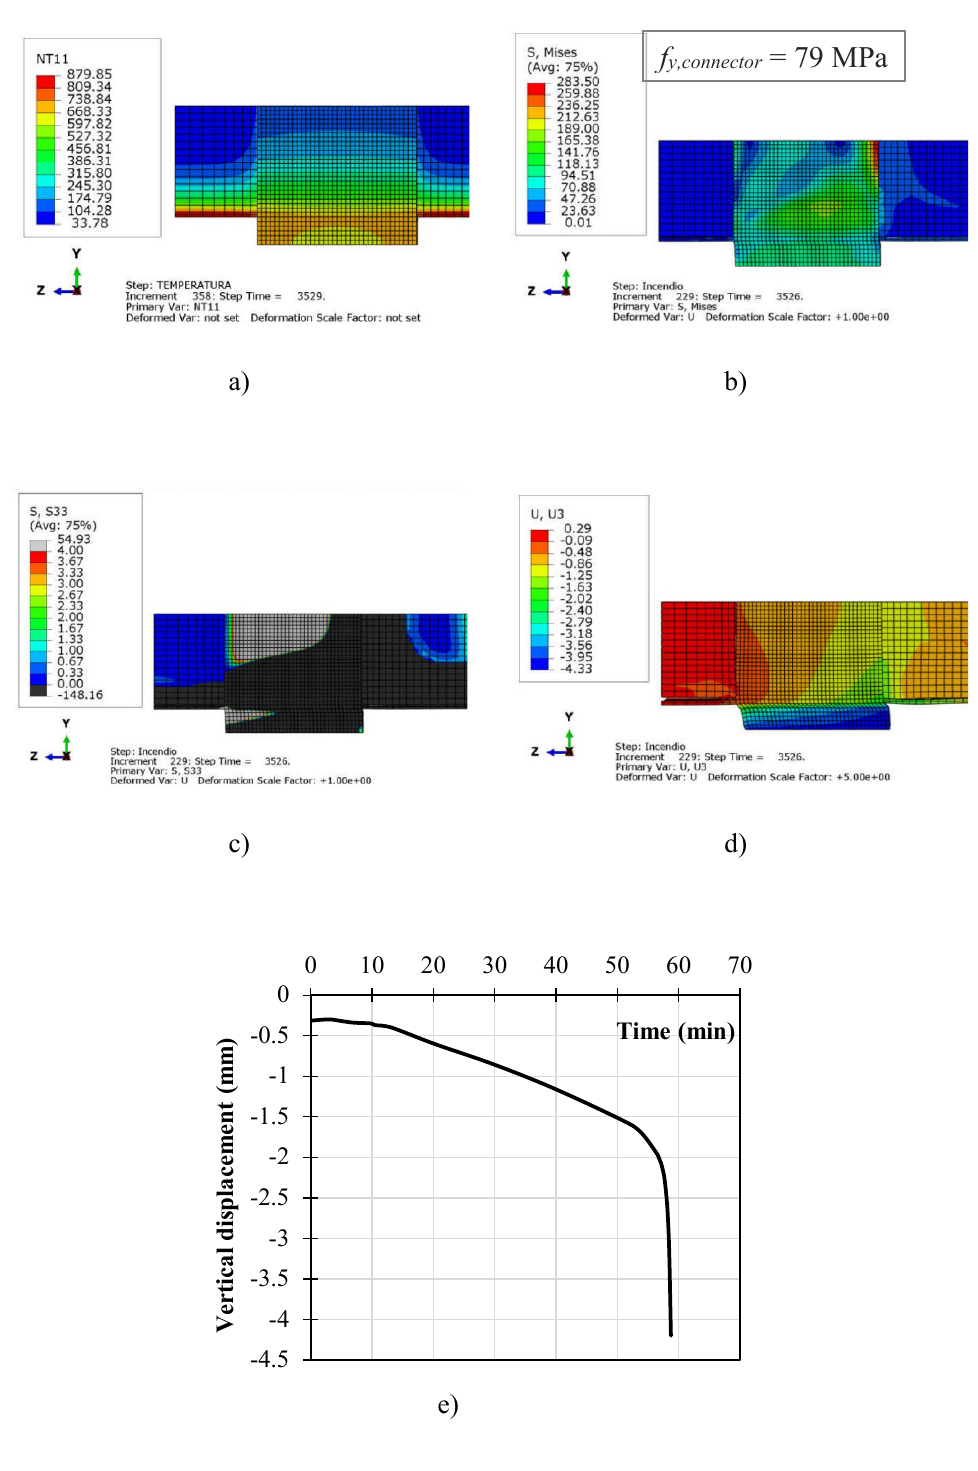
Figure 10. a) Temperature distribution, b) von Mises stresses, c) concrete tensile stresses, d) deformed configuration and e) displacement of the central point of the external surface of the connector of 400 mm diameter CFCCs with Shear Flat for the loading level of